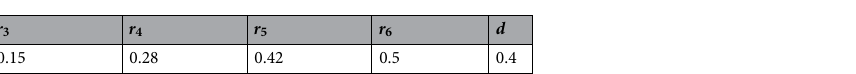
Figure 3. 3D crimping simulation model construction and dimension setting. ( a ) 3D crimping simulation model; ( b ) electrical contacts and stranded conductors; ( c ) crimping action part of the indenter.